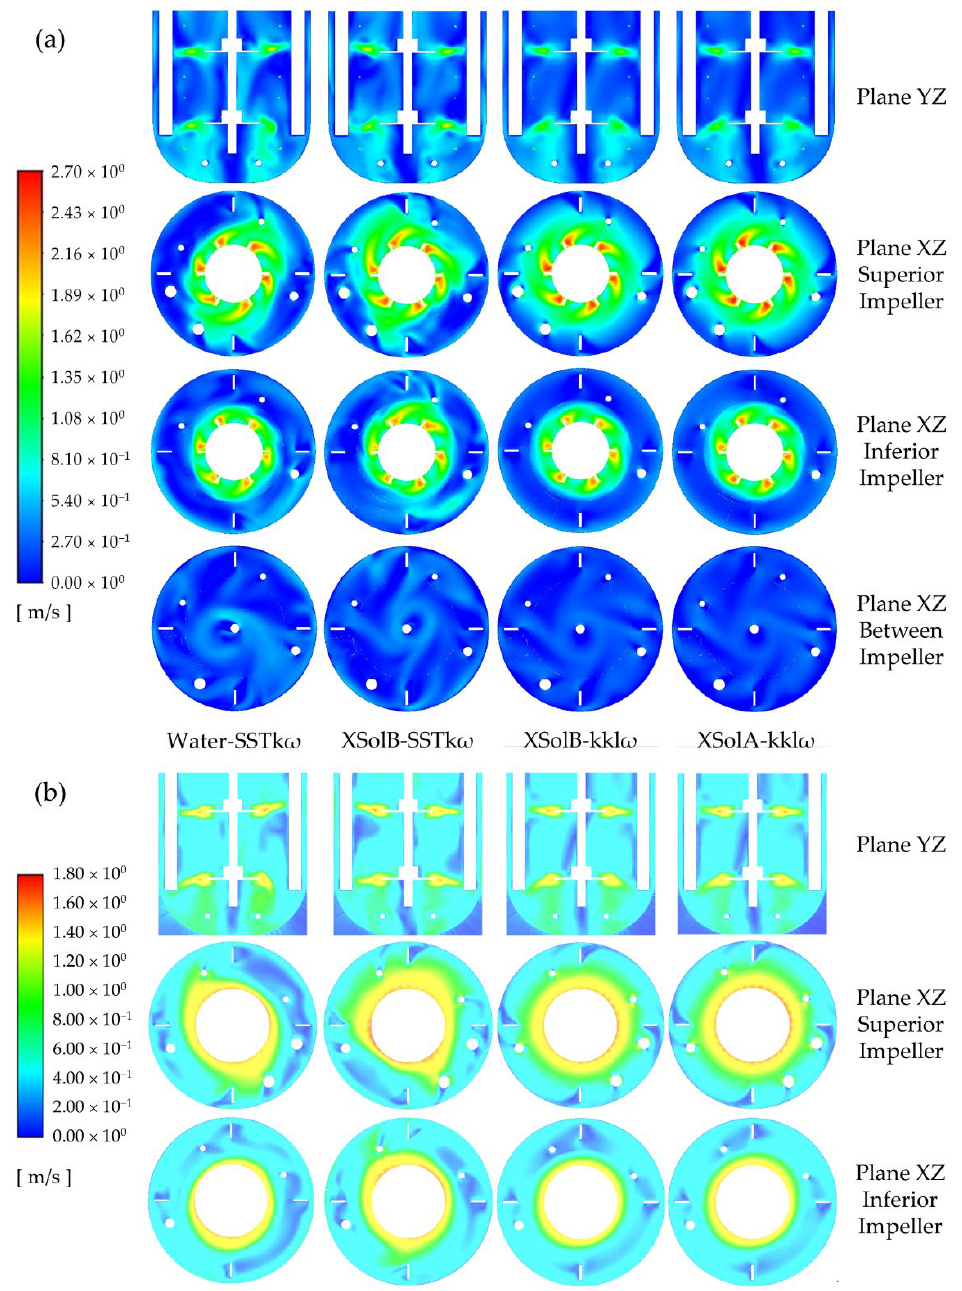
Figure 9. Comparison of the velocity magnitude. Contours of ( a ) instantaneous values, after the simulation of 58 impeller turns, and ( b ) time-averaged values over the last impeller turn.